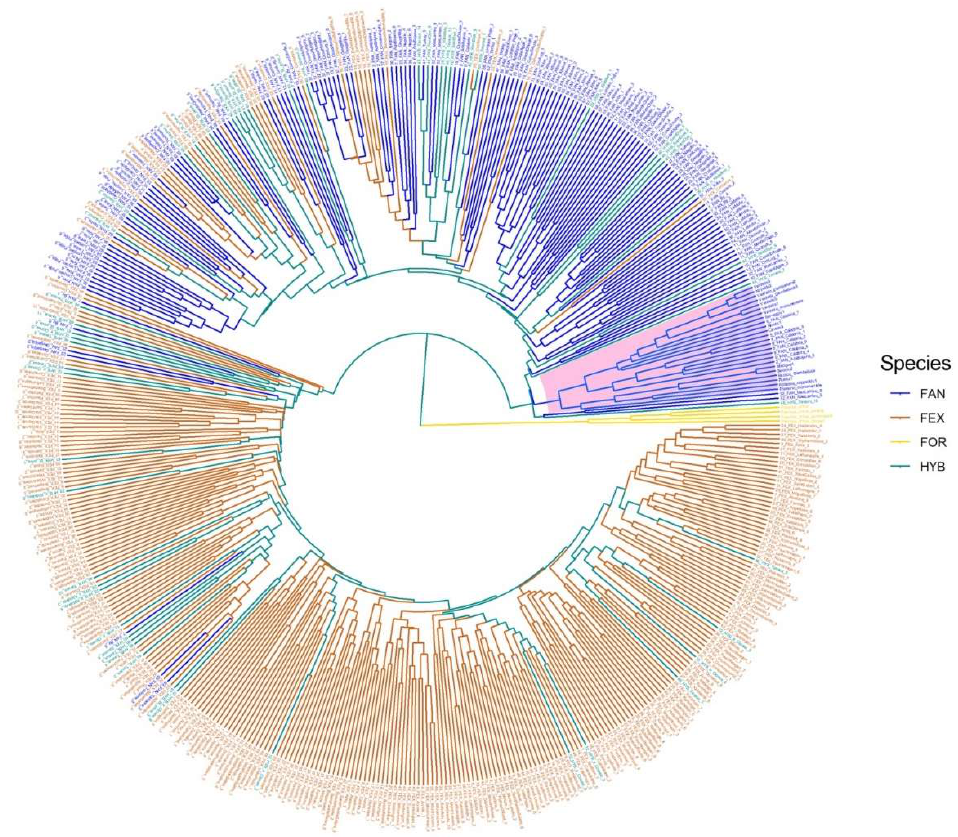
Figure 2. Genetic relationships among Fraxinus spp. accessions-based UPGMA and Bruvo’s distance, developed using unique nSSR profiles of sample belonging to set #2, including F. angustifolia (FAN), Fraxinus excelsior (FEX), and F. angustifolia x F. excelsior (HYB). F. ornus (FOR) was used as outgroup. Manna ash genetic profiles collected in the South of Italy are highlighted (in pink) in the phylogenetic tree.